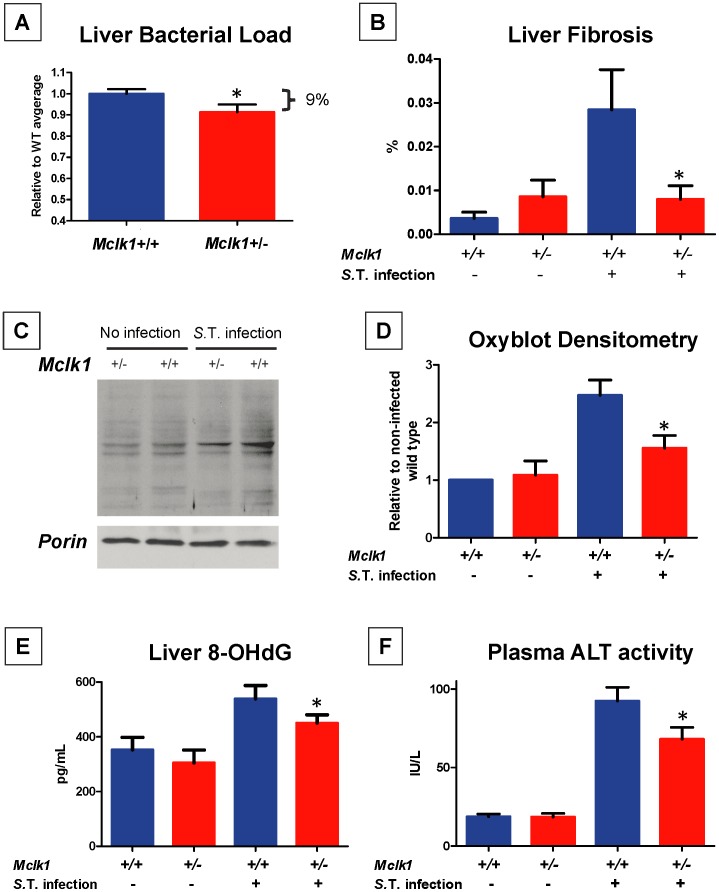
Favorable outcomes after infection of Mclk1
+/− mutants with Salmonella Typhimurium.
A. Liver bacterial loads were evaluated 40 days after infection in 3 months-old mice and were lower in Mclk1
+/− mutants. Three independent experiments were carried out. In each experiment, the average CFU per gram of tissue of each mutant (Mclk1
+/−) and wild type animal (Mclk1
+/+) was normalized to the average of the wild type group in that experiment. In total 35 wild type animals and 23 mutants were normalized in this way and the results pooled. The mean ± S.E.M. of the pool is shown. * indicates p<0.05. B. Liver fibrosis was determined in infected and uninfected groups on day 40 after infection using Picrosirius Red staining. The fraction of the area of sections that stain for collagen is shown. The mean ± S.E.M. are shown. There were 9–14 animals in each group. C. and D. Oxidative damage to proteins was evaluated by the Oxyblot assay. All samples used were from littermate pairs. A representative result is shown in C. The intensity of staining in each lane was quantified and normalized by that of the wild type in the same blot. The mean ± S.E.M. of each group is shown on the graph and paired t-tests were used for comparisons. E. Oxidative damage to DNA was determined by measuring 8-OHdG levels using purified total liver DNA. Littermate pairs were used (Mclk1
+/− vs. Mclk1
+/+): 5 pairs without infection and 6 pairs sacrificed 40 days after infection. The mean ± S.E.M. of each group is shown in the graph; paired t-test were used for comparisons. F. Plasma ALT activity was measured 40 days after infection. There were 8–14 animals in each group and the mean ± S.E.M. of each group are shown. For B−F, the differences between the mutant and wild type groups are significant with, but not without, infection at p<0.05. All experiments in this figure were carried out with males.